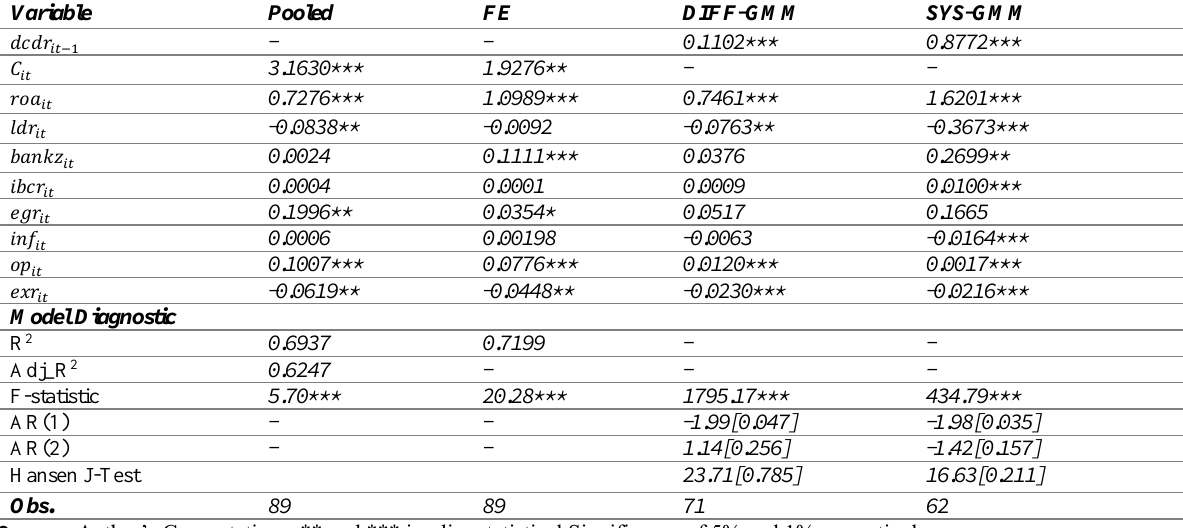
Table 5: Summary Results for static and the Dynamic